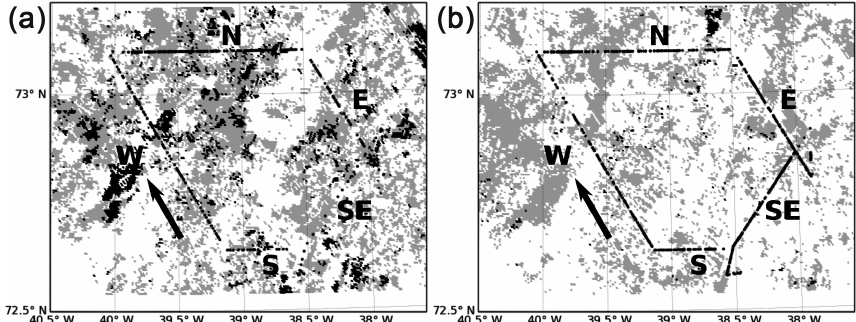
Figure 8. MODIS quality flags for 5 August (a) and 6 August (b) 2010. Grey color indicates low-quality retrieval; black indicates no retrieval. White areas have high-quality retrieval flags. Flight transects are as labeled in Figs. 5 and 6. The arrow indicates direction of flight. Flights started with the S transect and were flown